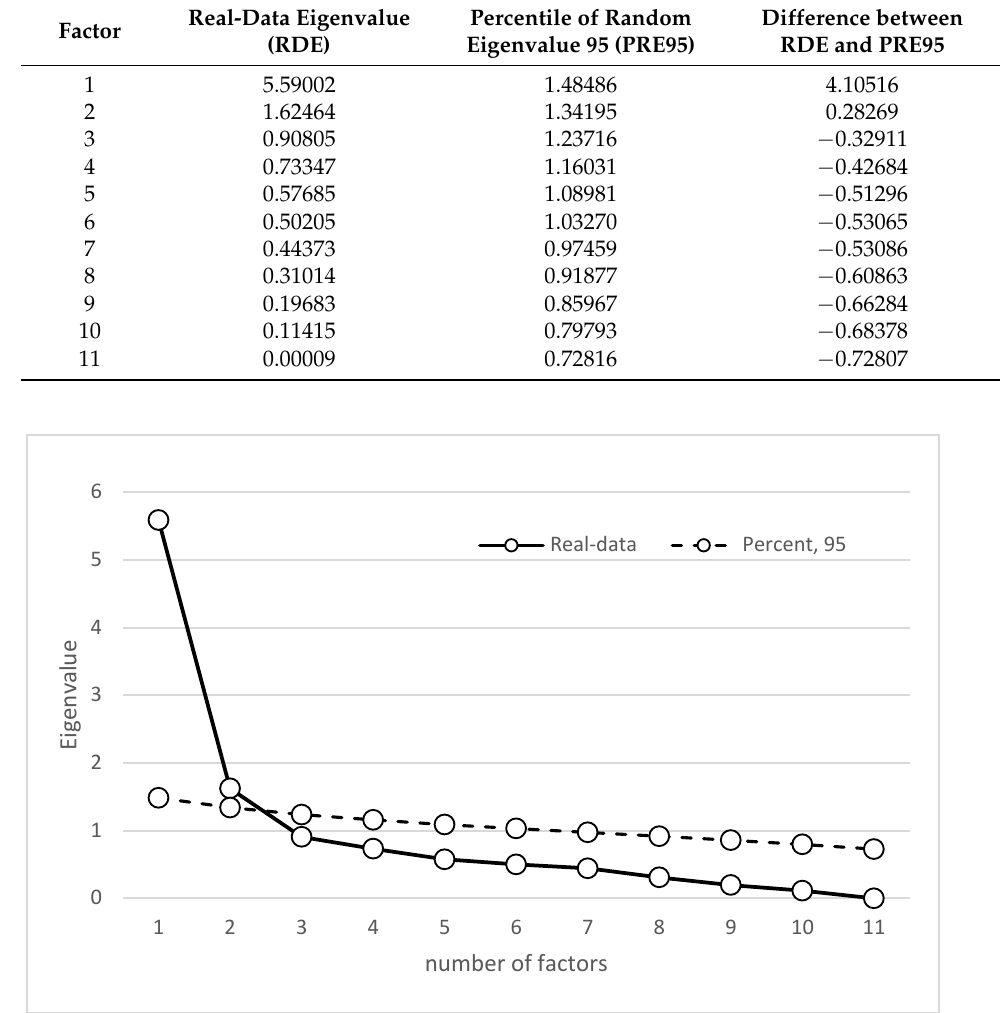
Figure 2. Scree plot with eigenvalues for real, average, and simulated data. Table 1. Factors for real and simulated data. Table 2. Rotated factor